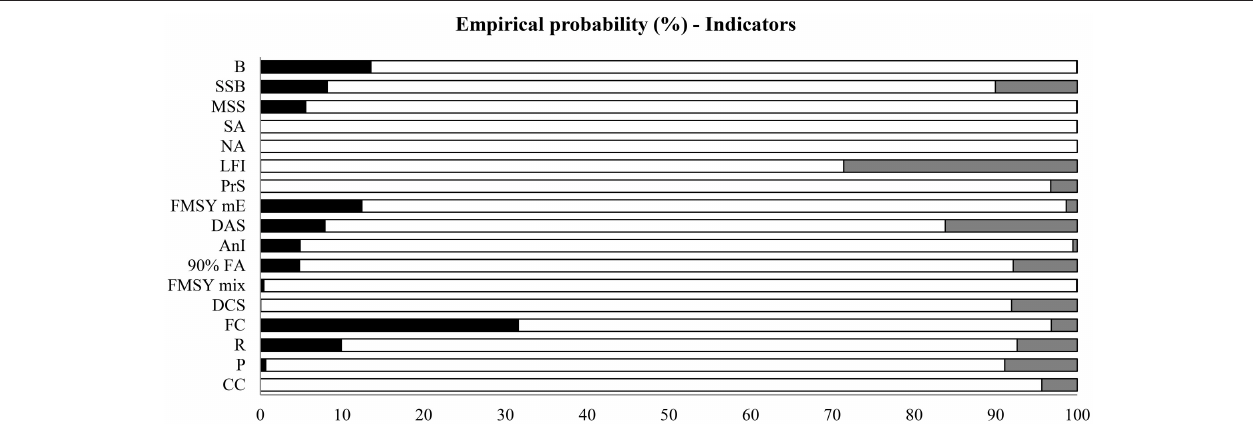
FIGURE 4 | Survey 1—AHP (Exploratory analysis): empirical probability to be first and to be last associated to the indicators according to stakeholders’ preferences, respectively, for ecological, pressure/impact, and economic components. B, Biomass of all species; SSB, Spawning stock biomass; MSS, Mean size of the spawners; SA, Spawning areas; NA, Nursery areas; LFI, Proportion of large fish; PrS, Proportion of elasmobranchs; F MSY mE, Fishing mortality at the MSY of the most exploited species; DAS, Discard rate of all the exploited species; AnI, Area not impacted by fishing gears; 90% FA, Area in which 90% of the fishery by metier, month, and year